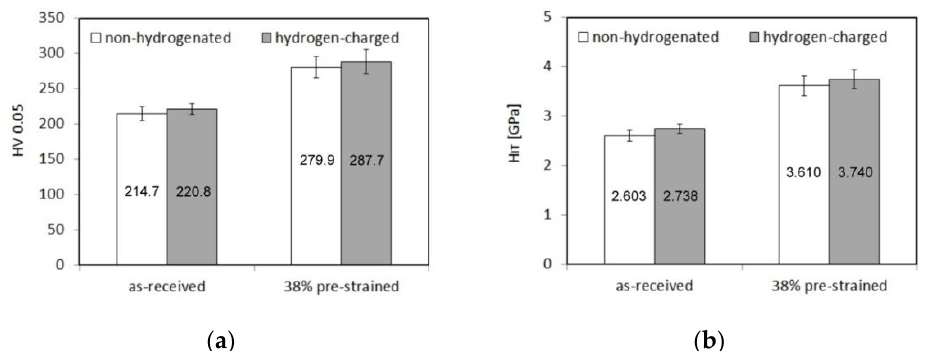
Figure 14. The effects of plastic pre-straining and cathodic hydrogen charging of studied 316H material on its: ( a ) micro-hardness and ( b ) nano-hardness.